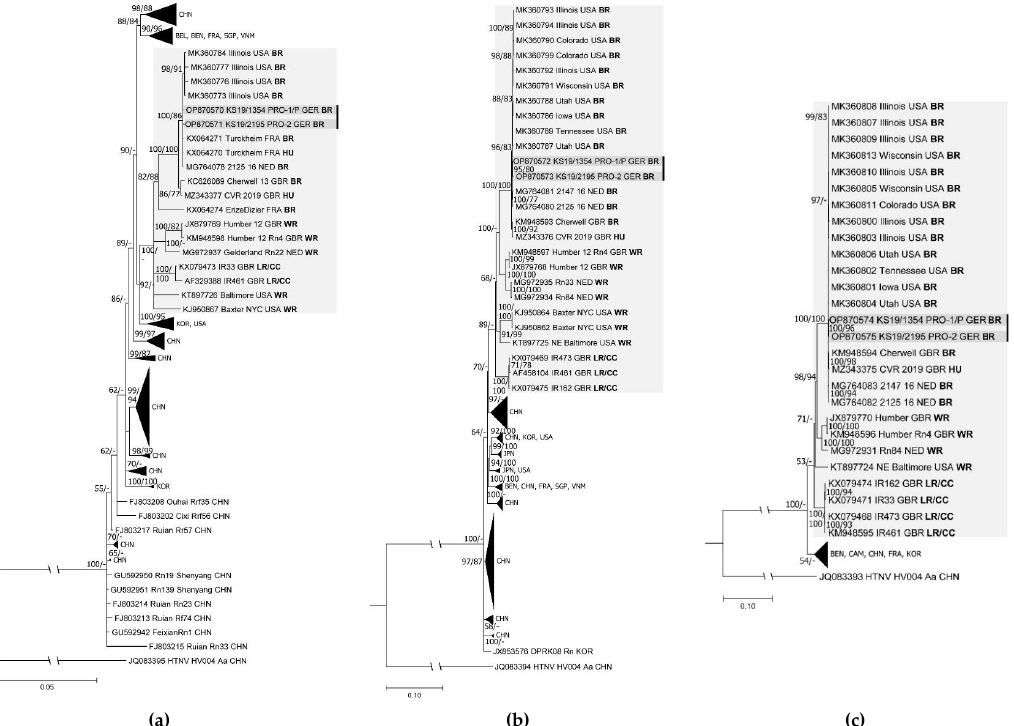
Figure 3. Phylogenetic trees of complete coding Seoul virus (SEOV) sequences of the S, M, and L segments. ( a ) The consensus tree of the complete coding S segment was derived from Bayesian analyses with 8 × 10 6 generations using the TIM1 substitution model with gamma distribution and invariant sites. The maximum likelihood reconstructions were performed using the TrN substitution model with gamma distribution and invariant sites on a sequence length of 1290 nucleotides and 1000 bootstrap replicates. ( b ) The complete coding M segment consensus tree was reconstructed using Bayesian algorithms with 8 × 10 6 generations and the TIM1 substitution model including gamma distribution and invariant sites. Maximum likelihood analyses used the GTR substitution model including gamma distribution and invariant sites based on a sequence length of 3402 nucleotides and 1000 bootstrap replicates. ( c ) The L segment complete coding consensus tree was reconstructed using the GTR substitution model with gamma distribution and invariant sites for Bayesian and maximum likelihood algorithms with 1 × 10 7 generations and 1000 bootstrap replicates, respectively, with an alignment length of 6456 nucleotides. Bootstrap values were only transferred from the maximum likelihood trees to establish consensus trees if the branches were identical. Posterior probabilities are given before and bootstrap values behind or below slashes. Relevant clades are highlighted in a light grey background. Sequences derived from the same outbreak are marked by a black bar, while novel sequences from the pet rats are indicated in a darker grey background. Country abbreviations: BEL, Belgium; BEN, Benin; CAM, Cambodia; CHN, China; FRA, France; GBR, Great Britain; GER, Germany; JPN, Japan; KOR, Korea; NED, the Netherlands; SGP, Singapore; USA, United States of America; VNM, Vietnam. Other abbreviations: HU, human; PRO-1/P, pet-rat owner 1/patient; PRO-2, pet-rat owner 2; Rn, Rattus norvegicus ; BR, breeder rat; CC, cell culture isolate; LR, laboratory rat; WR, wild rat. The categorization of the rats was according to